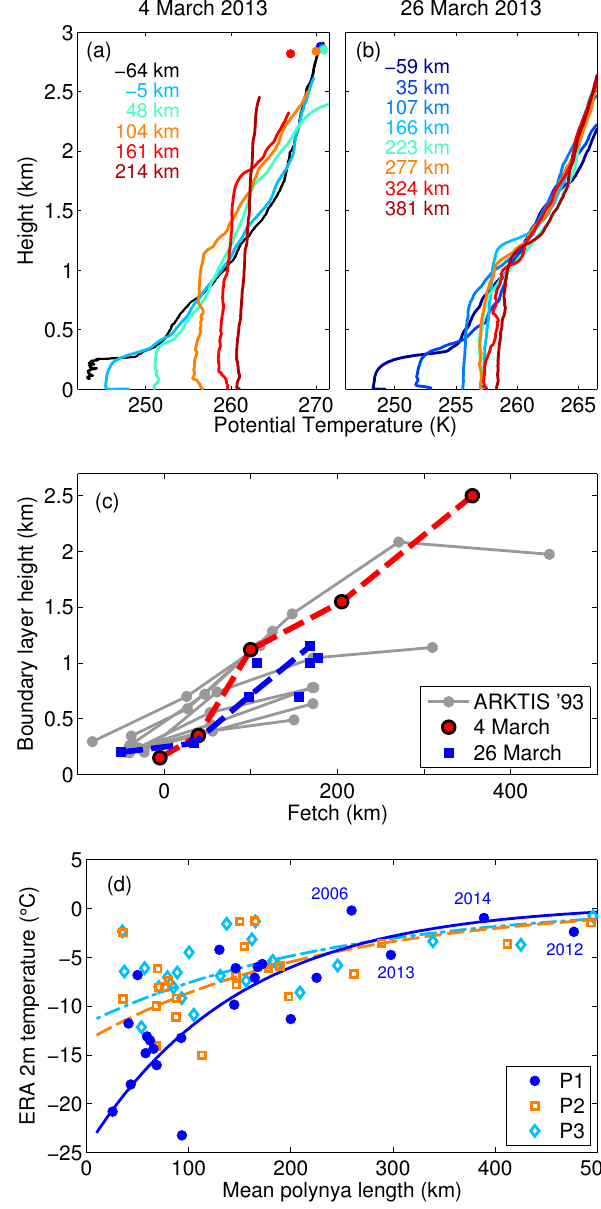
Figure 3. Potential temperature profiles from aircraft (black) and dropsonde (colored) data as a function of distance from the ice edge on (a) 4 March and (b) 26 March 2013. The dots are aircraft mea- surements at the dropsonde release points. Boundary layer height for those 2 days as a function of open-water fetch and data from ARKTIS’93 (Brümmer, 1997) for comparison (gray) (c) . JFM mean ERA-Interim 2m air temperature at three positions (P1–P3) north and west of Svalbard (see text) during times with wind from NE as a function of polynya length from 1992 to 2014 (symbols) (d) . The lines represent exponential